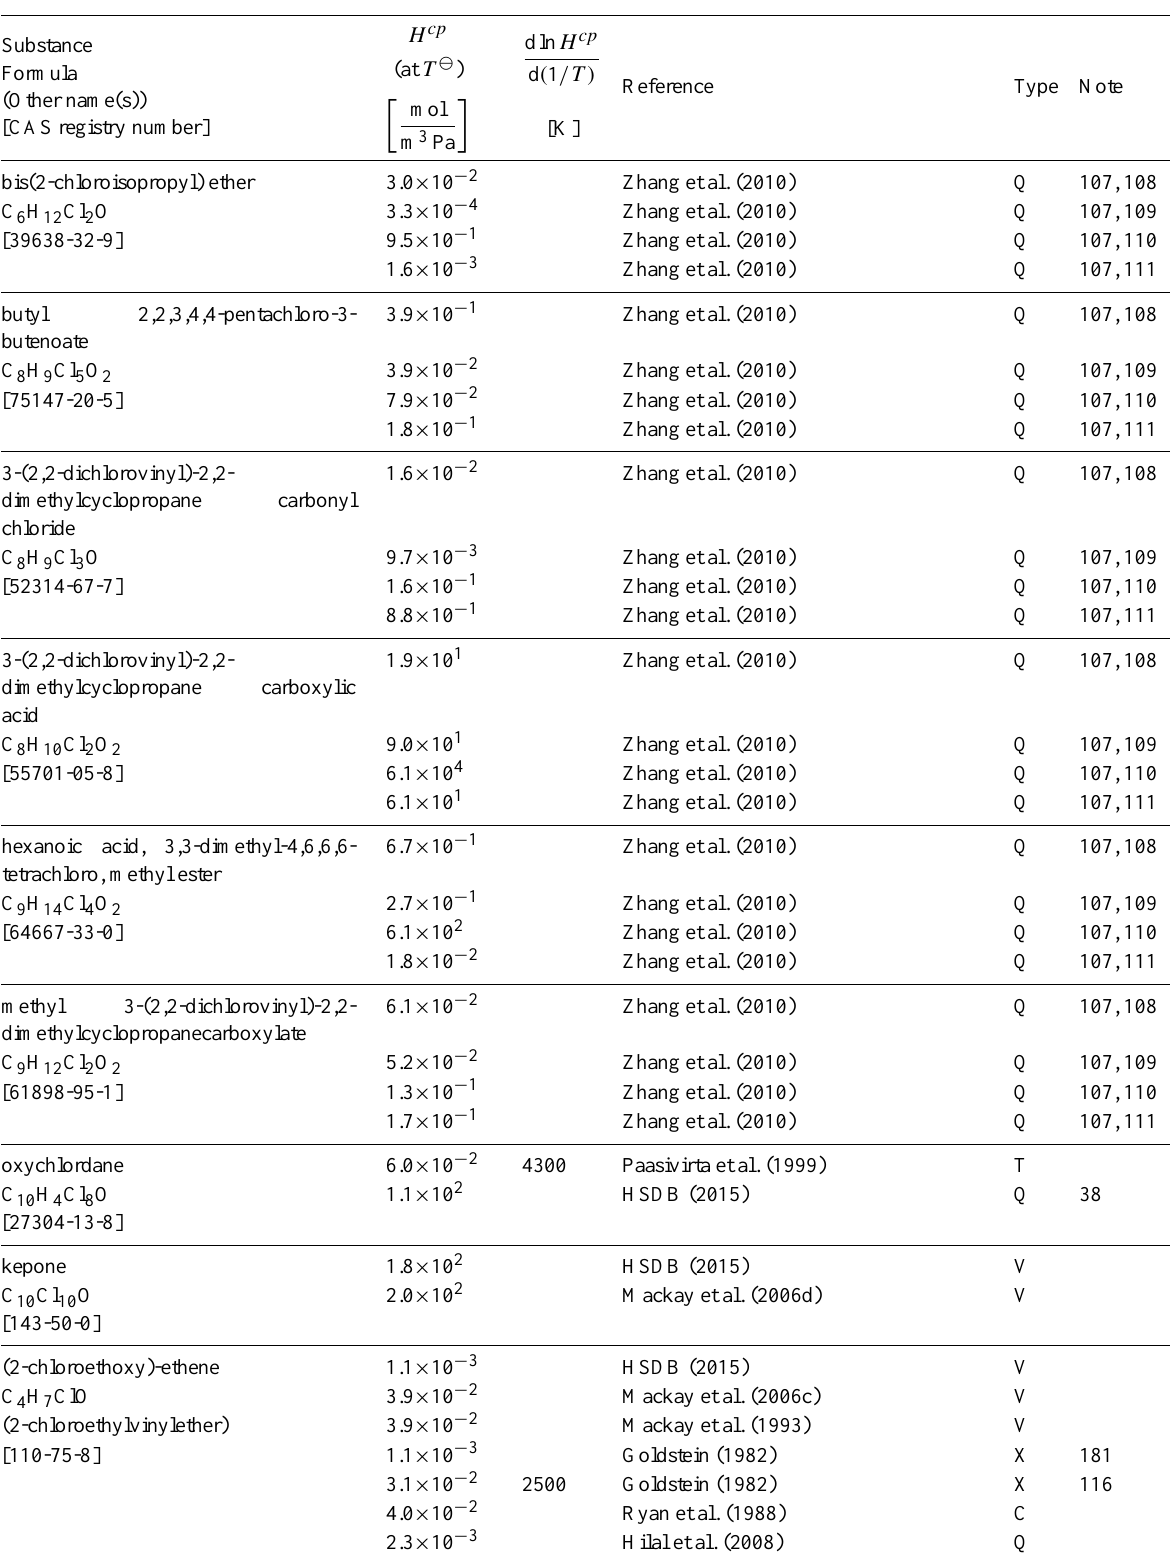
Table 6: Henry’s law constants for water as solvent